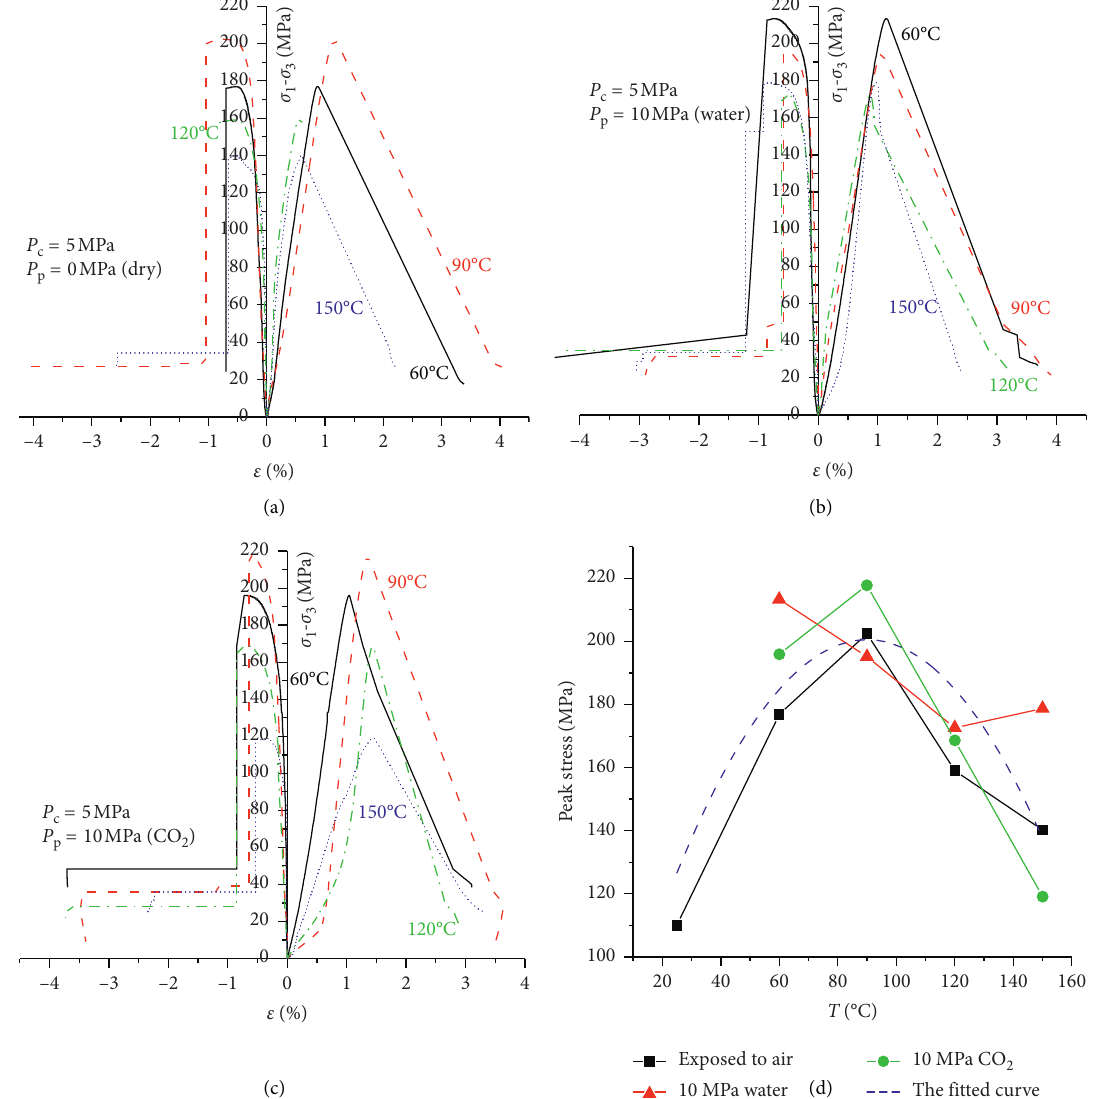
Figure 4: Results of conventional triaxial compression experiments on granite specimens: (a) stress-strain curves of granite specimens under 5MPa confining pressure and different temperature conditions; (b) stress-strain curves of granite specimens under water injection (10MPa) and different temperature conditions; (c) stress-strain curves of granite specimens under CO 2 injection (10MPa) and different temperature conditions; (d) the relationship between the peak stress of granite specimens and the temperature at the same effective confining pressure (5MPa). Table 3: Mechanical properties of granite specimens under fluid injection and high temperature conditions.